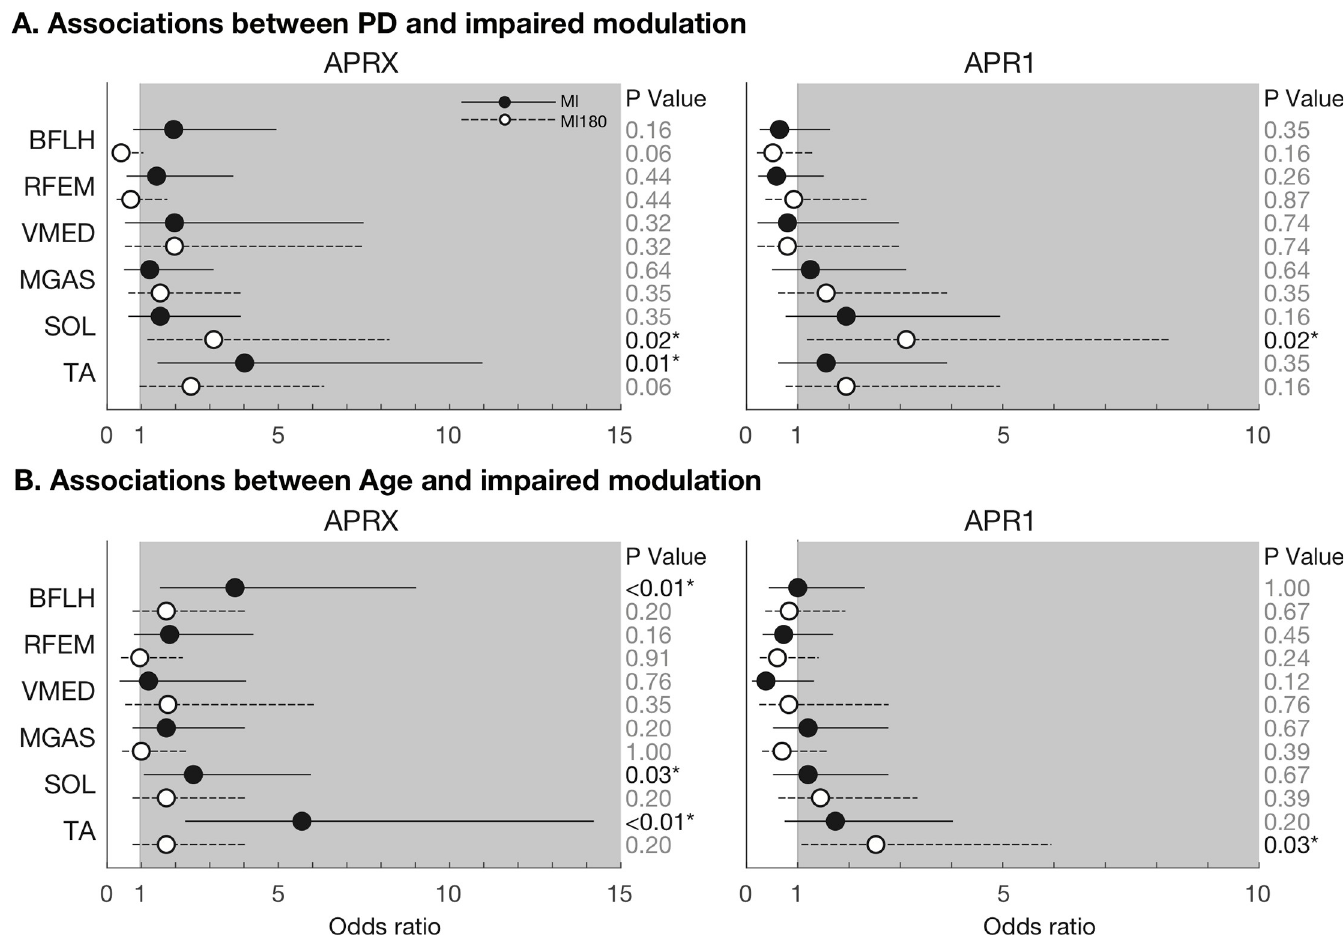
Fig 2. Associations between PD (A) and Age (B) and impaired modulation in analyses of individual muscles. Associations are described as Odds Ratios (OR) calculated separately using both MI and MI180 modulation indices derived from both APR1 and APRX time bins. Solid lines and dots represent the OR and 95% confidence limits for modulation index MI; dashed lines and open dots represent modulation index MI180. Odds ratios > 1 (shaded area) indicate that the presence of the risk factor (PD or Age) is strongly associated with the presence of impaired modulation for that muscle.